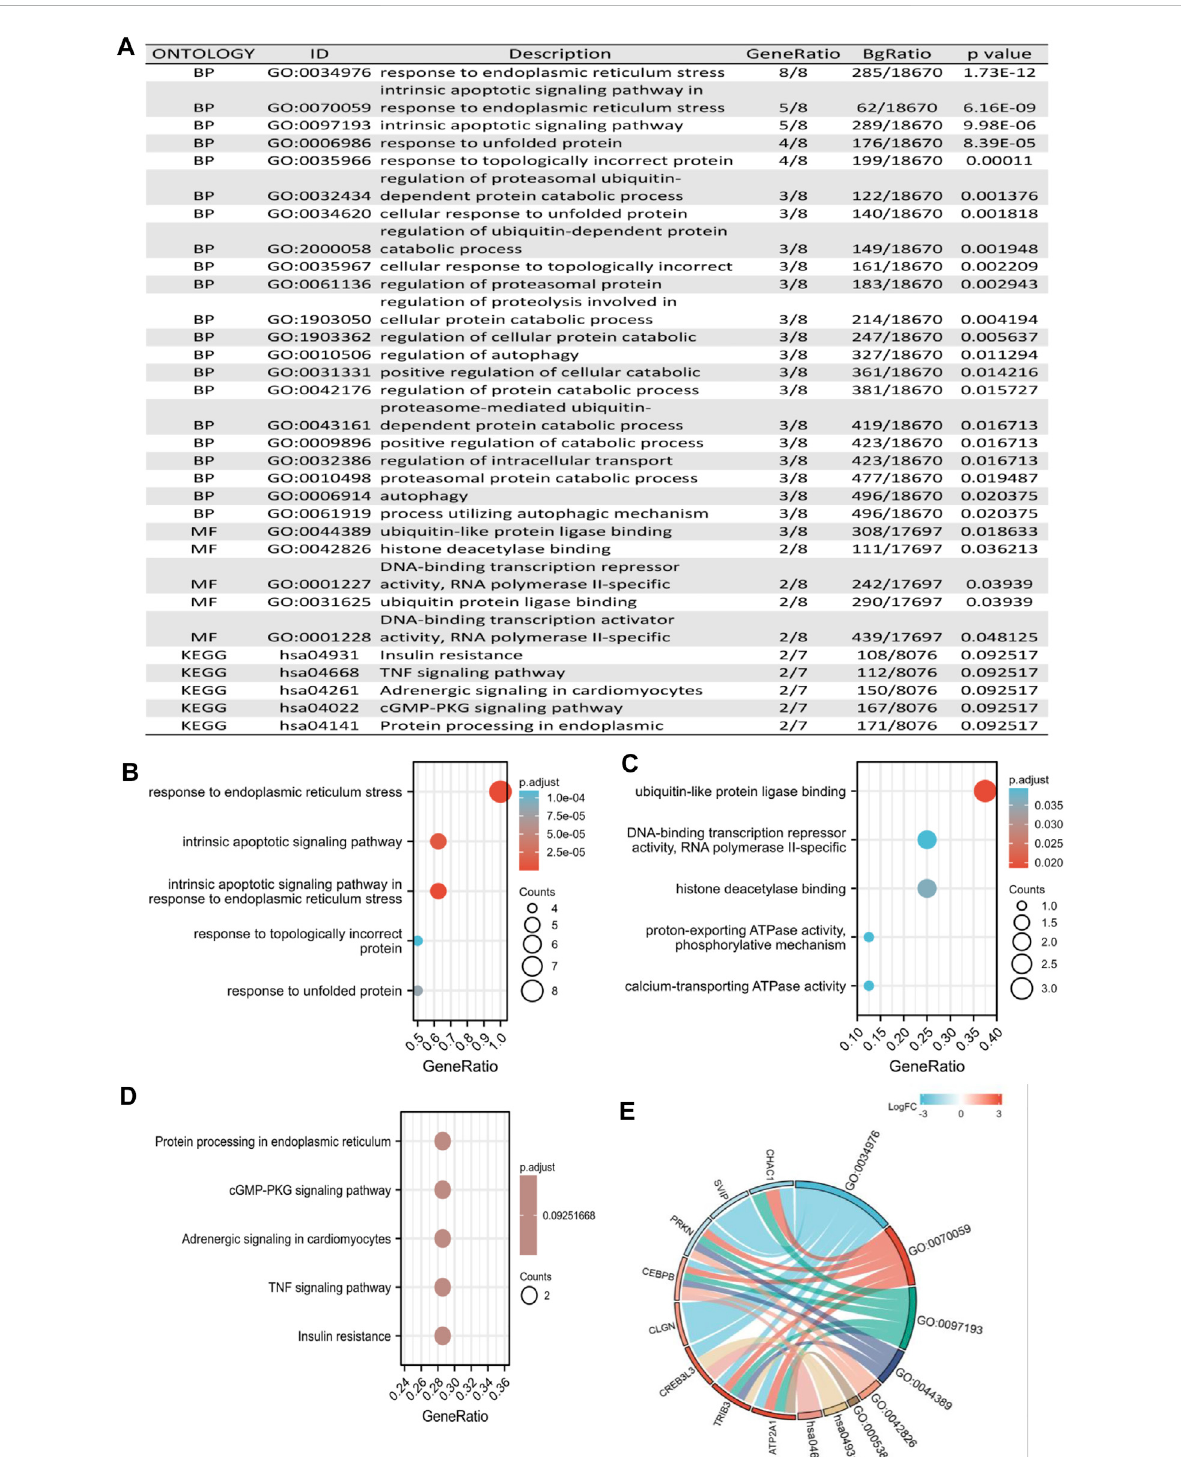
Frontiers in Molecular